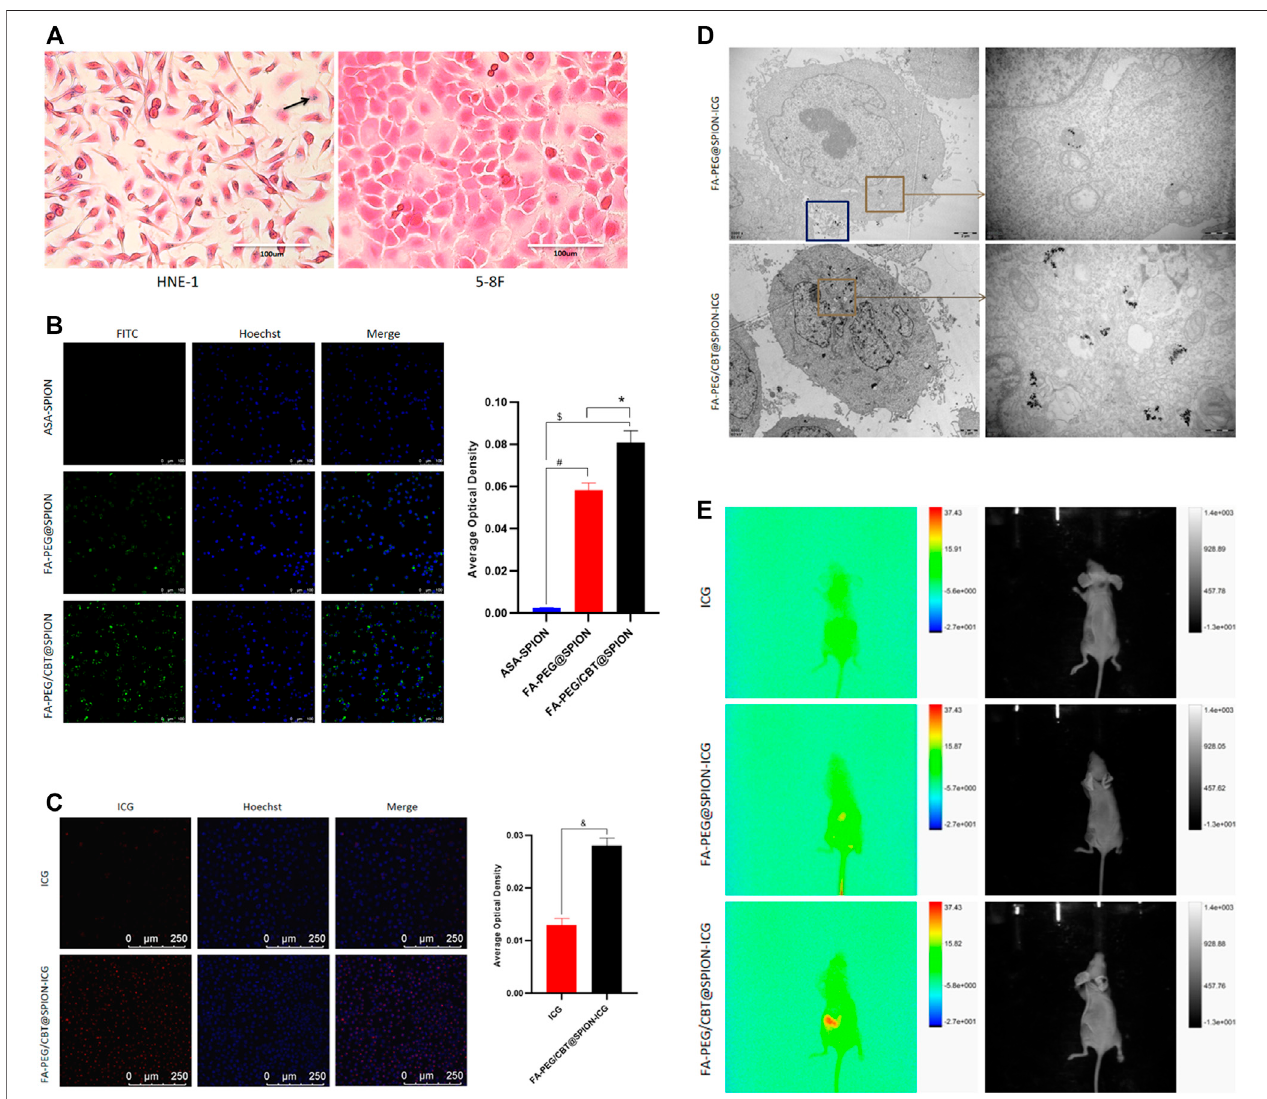
FIGURE 3 | Prussian blue staining (A) and Hoechst staining (B) (C) of different formations under various conditions. #Stands for p < 0.05 ASA@SPION versus FA- PEG@SPION. $Stands for p < 0.05 ASA@SPION versus FA-PEG/CBT@SPION. * Stands for p < 0.05 FA-PEG@SPION versusFA-PEG/CBT@SPION. &Stands for p < 0.05 ICG versus FA-PEG/CBT@SPION-ICG. TEM results of HNE-1 cells after cellular uptake of FA-PEG@SPION-ICG and FA-PEG/CBT@SPION-ICG (D) . Multimodal small animal imaging after injection of different formations at 8 h (E)